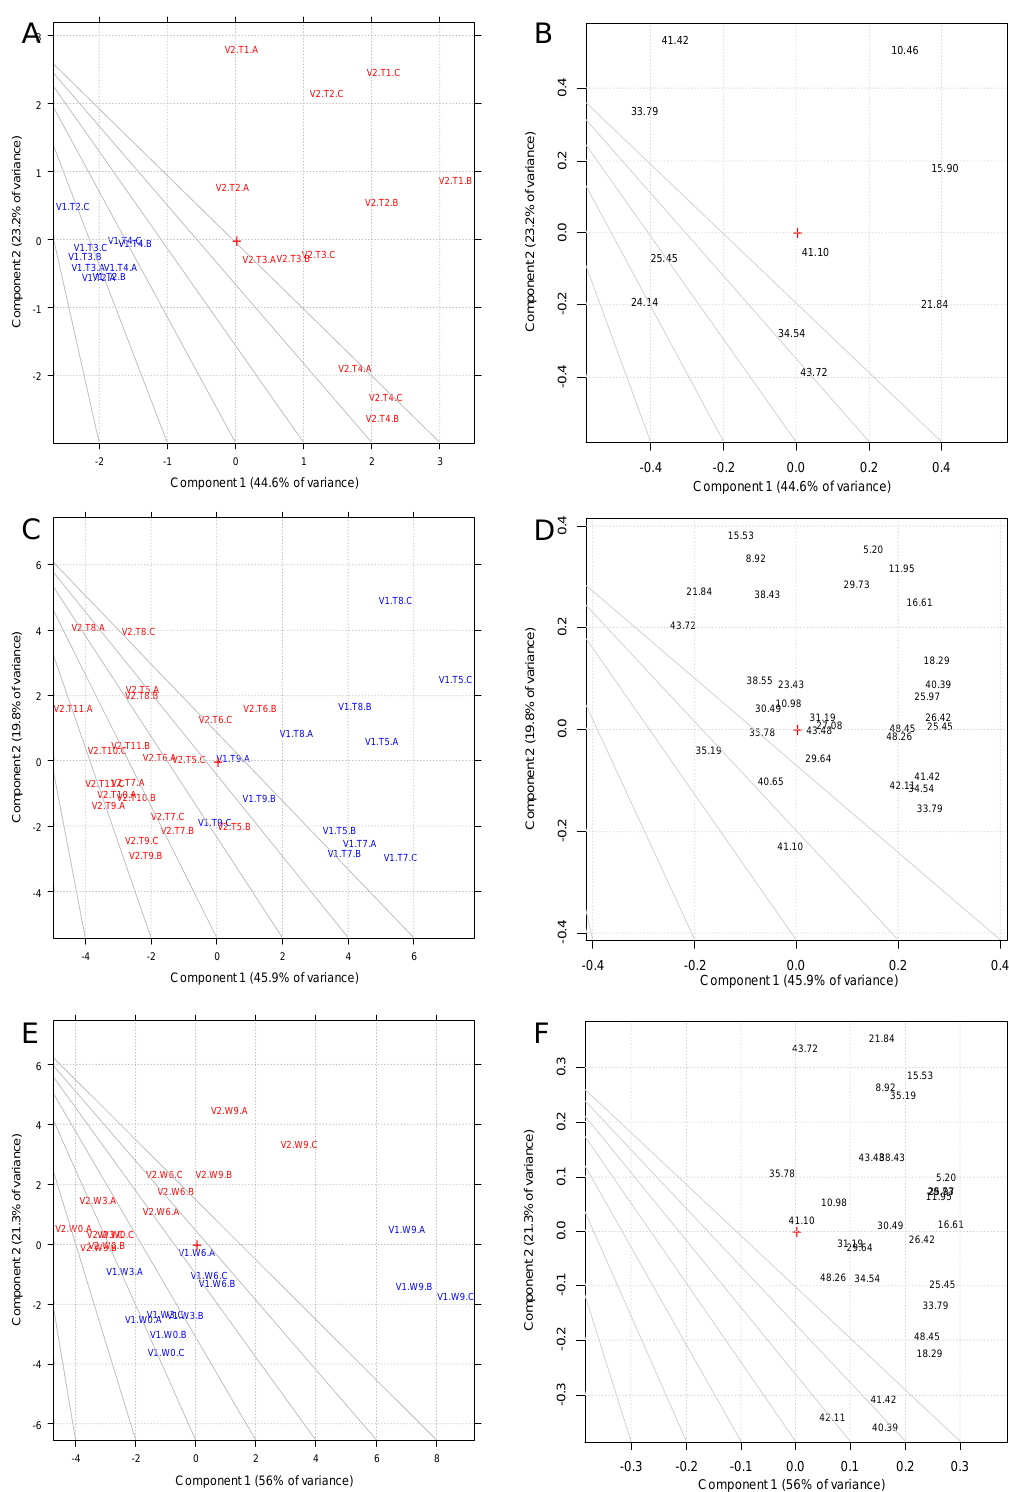
Figure 2. PCA of GC / MS peaks. ( A ) PC1 vs. PC2 score plot for must samples; ( B ) PC1 vs. PC2 loading Figure 2. PCA of GC/MS peaks. A ) PC1 vs. PC2 score plot for must samples; B ) PC1 vs. PC2 loading plot for plot for must samples; ( C ) PC1 vs. PC2 score plot for fermentation and stabilization samples; ( D ) PC1 must samples; C ) PC1 vs. PC2 score plot for fermentation and stabilization samples; D ) PC1 vs. PC2 loading plot vs. PC2 loading plot for fermentation and stabilization samples; ( E ) PC1 vs. PC2 score plot for bottled for fermentation and stabilization samples; E ) PC1 vs. PC2 score plot for bottled samples; F) PC1 vs. PC2 loading samples; ( F) PC1 vs. PC2 loading plot for bottled samples. Loadings are indicated with their retention plot for bottled samples. Loadings are indicated with their retention times as labels. Blue font indicates V1 times as labels. Blue font indicates V1 samples; red font indicates V2 samples. A, B, C into the PCA samples; red font indicates V2 samples. A, B, C into the PCA plot indicates the three replicates. plot indicates the three